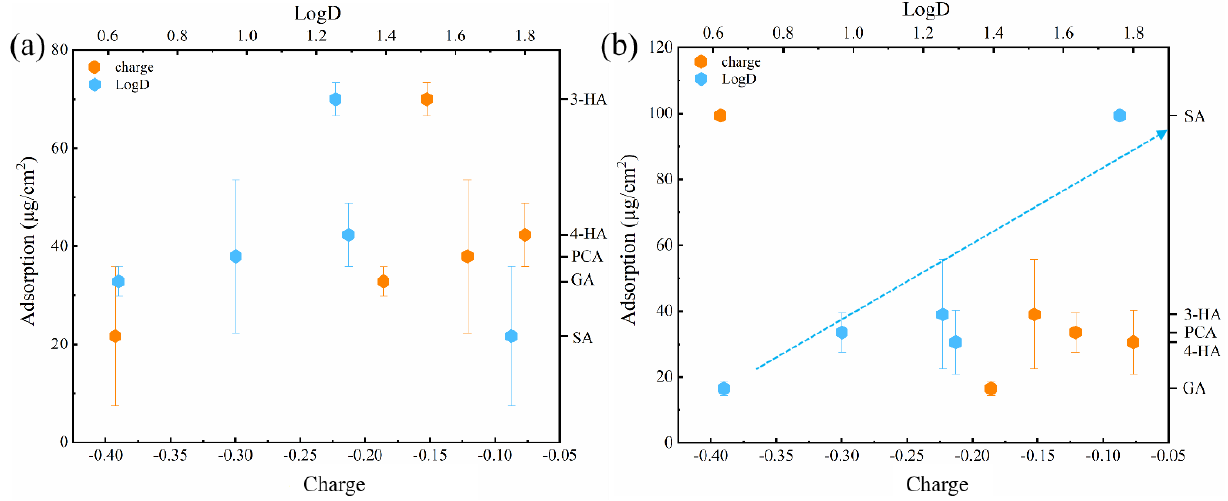
Figure 2. The correlations between amounts of phenolic acids adsorbed onto two membranes (( a ), for RC membrane; ( b ), for PA membrane) and two important physicochemical properties (charge and the logD values) of phenolic acids. Experimental conditions: feed concentration = 10 mM and 25 ± 2 °C. (The error bar is for adsorption).